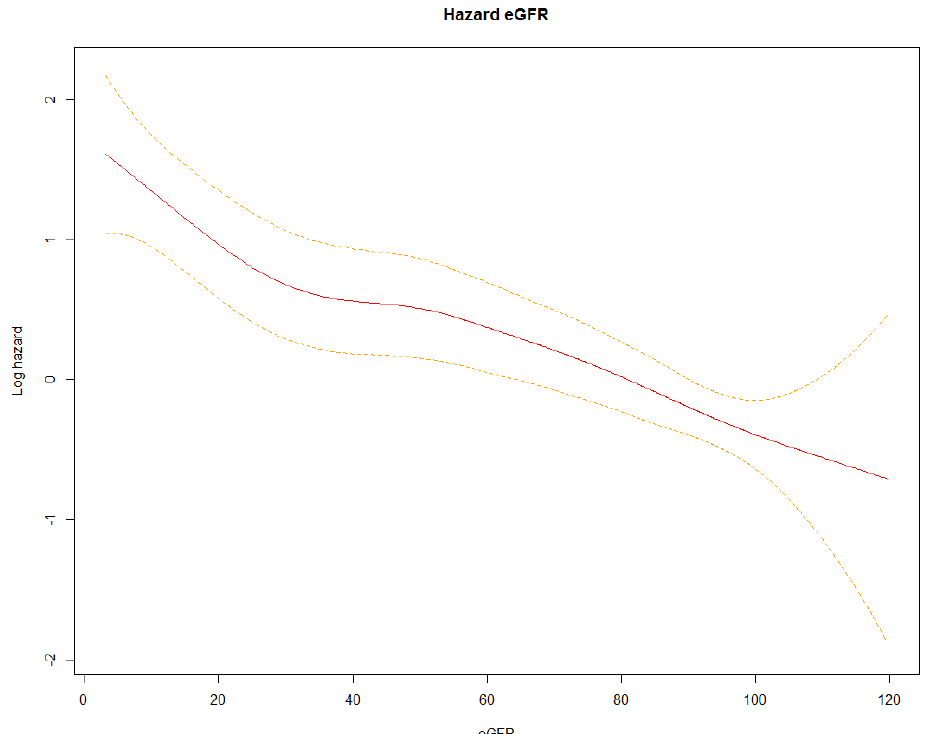
Figure 2. Spline function of the risk of mortality. Red line: Log hazard value; Dotted yellow lines: Confidence interval values.